Question: Condense the content of this figure into a single sentence.
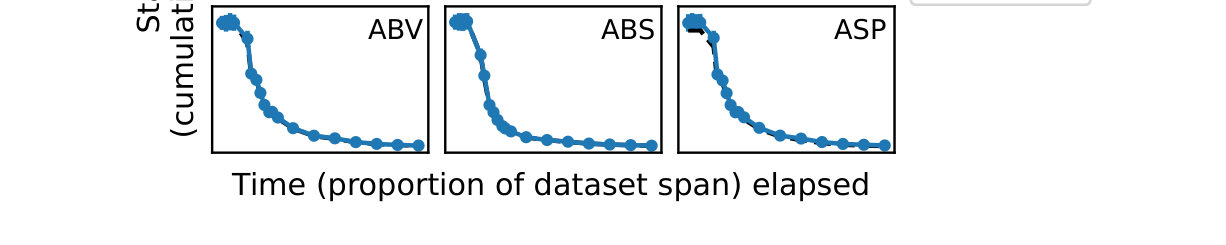
Answer: 3: The ratio between the one-way bootstrap standard error (SE) estimates [19] and the vanilla sample SE estimates for (Left) ABV, (Middle) ABS, and (Right) ASP. The error bars represent the 95% confidence interval for the one-way bootstrap SE estimates.